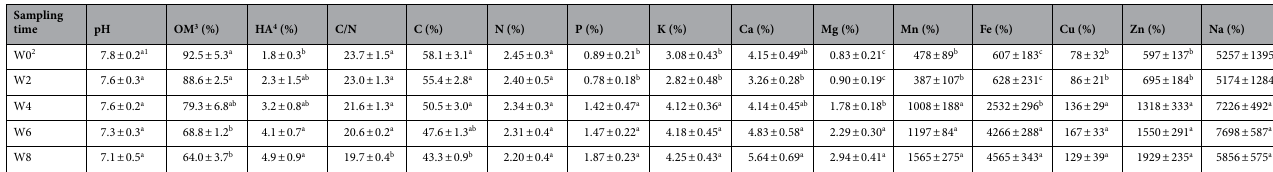
Table 1. The chemical properties of chicken manure at different sampling stage. 1 Different letters indicate significantly different results by LSD tests at p < 0.05. 2 0, 2, 4, 6, 8 week after compost. 3 Organic matter. 4 Humic